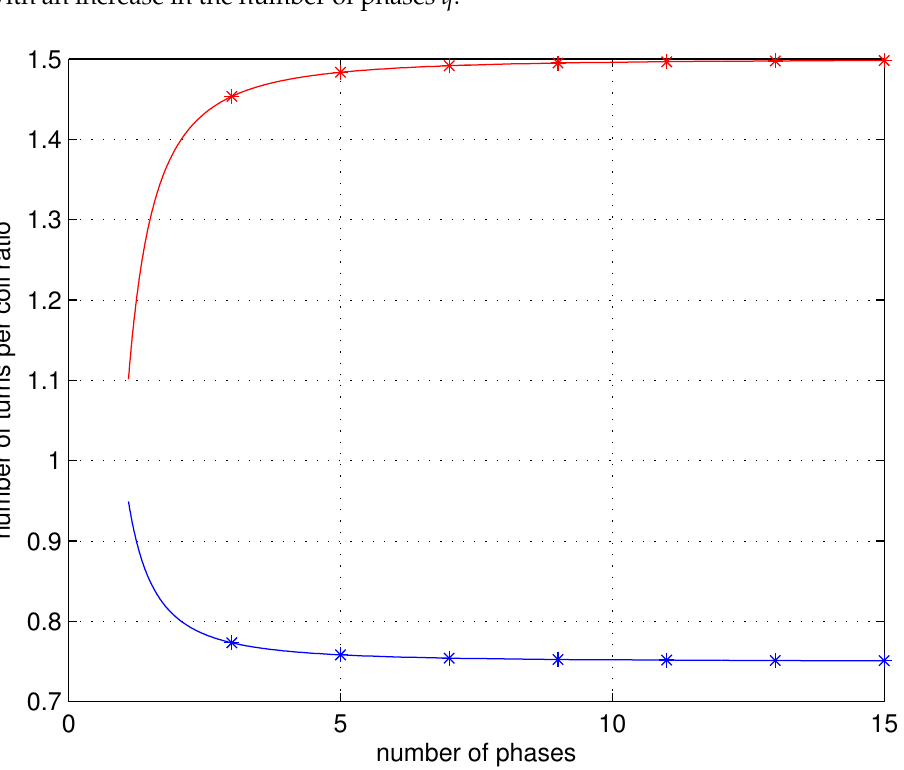
N H N L , (blue) N N